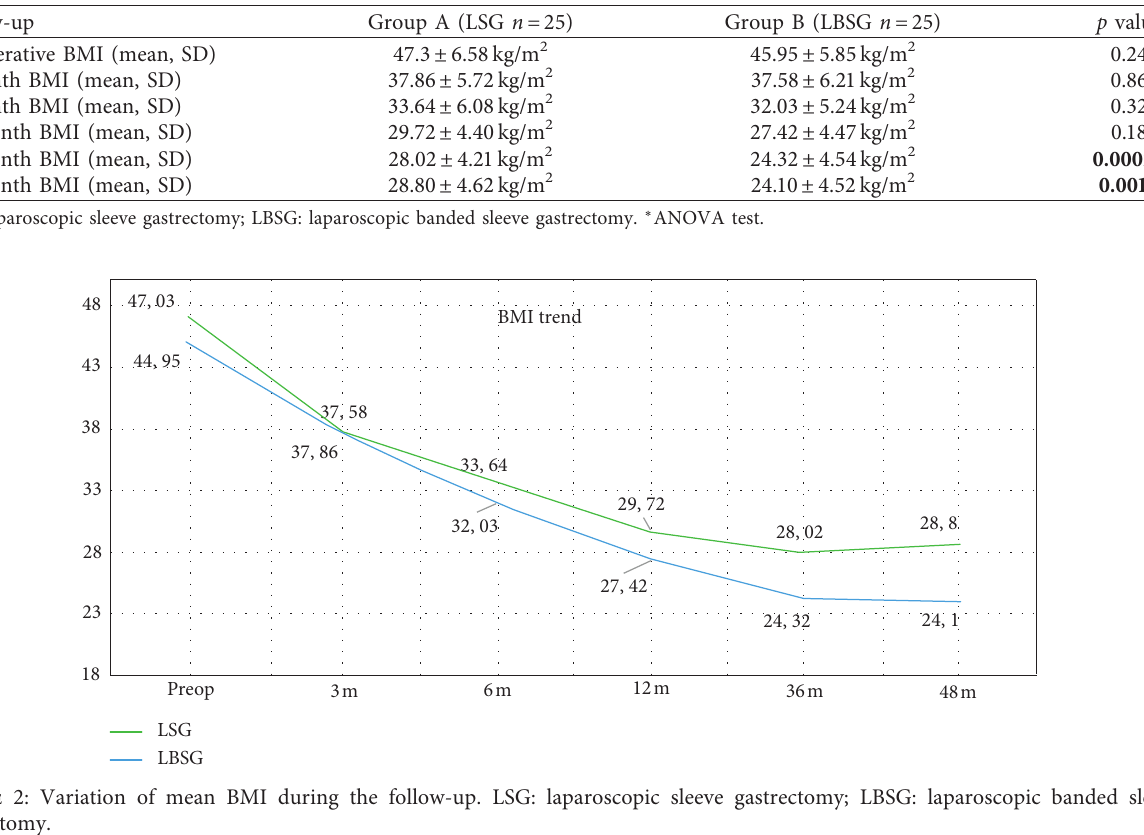
Table 2: Differences in BMI at each follow-up up to 4 years.